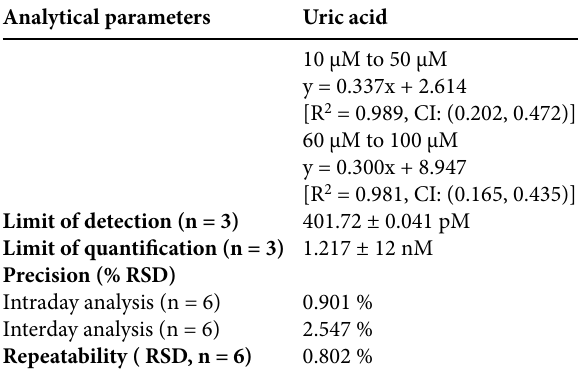
Table 3: Analytical characteristics of the N-GQDs based fluorescent biosensor for determination of